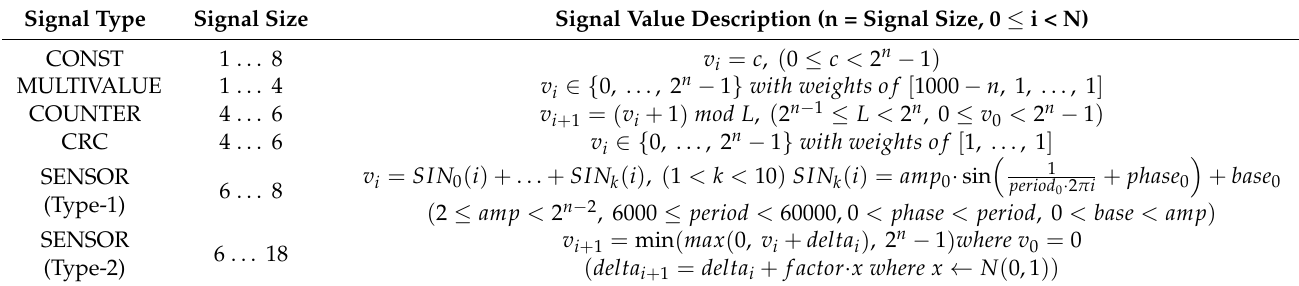
Table 3. Signal types, range of signal size, and description of how they are generated on the synthetic CAN bus. Signal